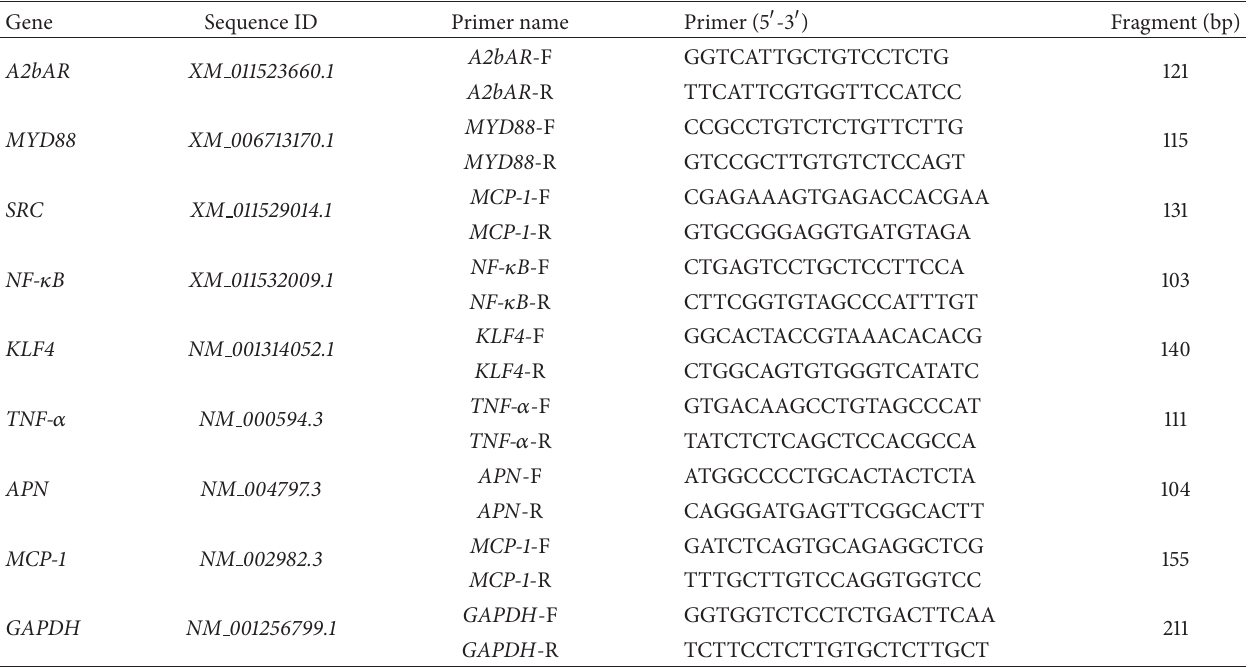
Table 1: Primers used in real-time PCR of target gene.